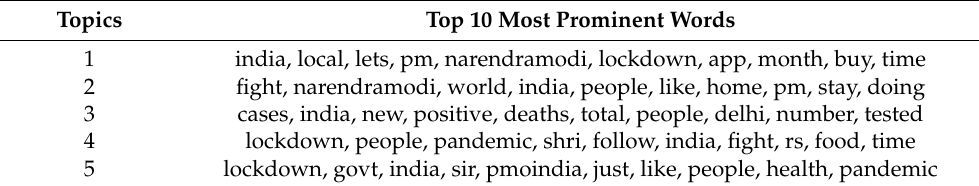
Table 3. Most prominent words using LDA for first dataset.